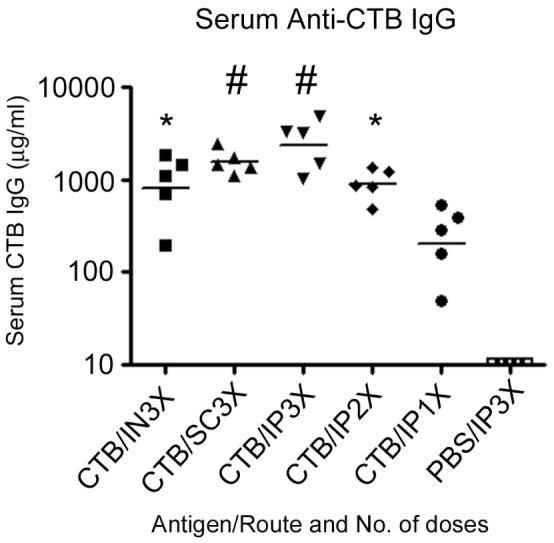
Serum CTB-specific IgG concentrations at 14 days following the final/only immunization via the intranasal (IN), subcutaneous (SC), or intraperitoneal (IP) route.Each symbol represents the serum anti-CTB antibody concentration for an individual mouse. The horizontal lines represent the geometric mean concentration per group (n = 5). Statistical differences between groups were analyzed using ANOVA with Tukey-Kramer post-test analysis (# P<0.001 and *P<0.05 versus the CTB/IP1X group).